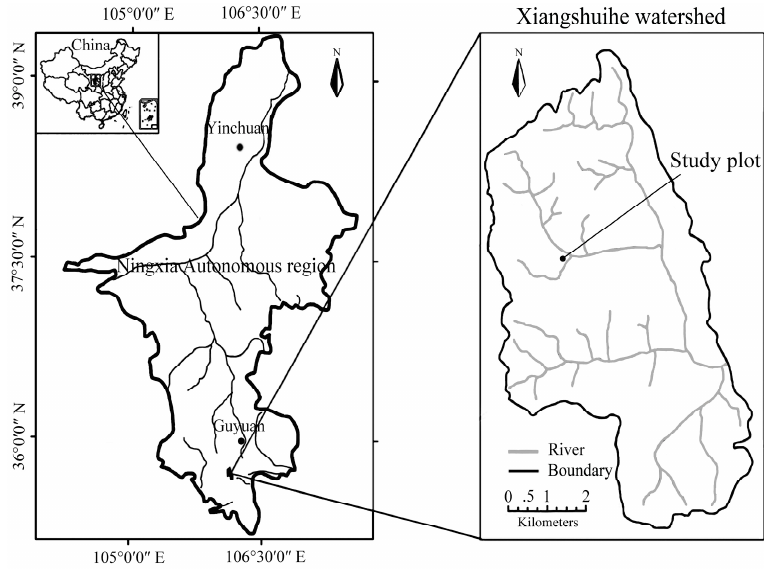
Figure 1. The location of the study site and study plot.